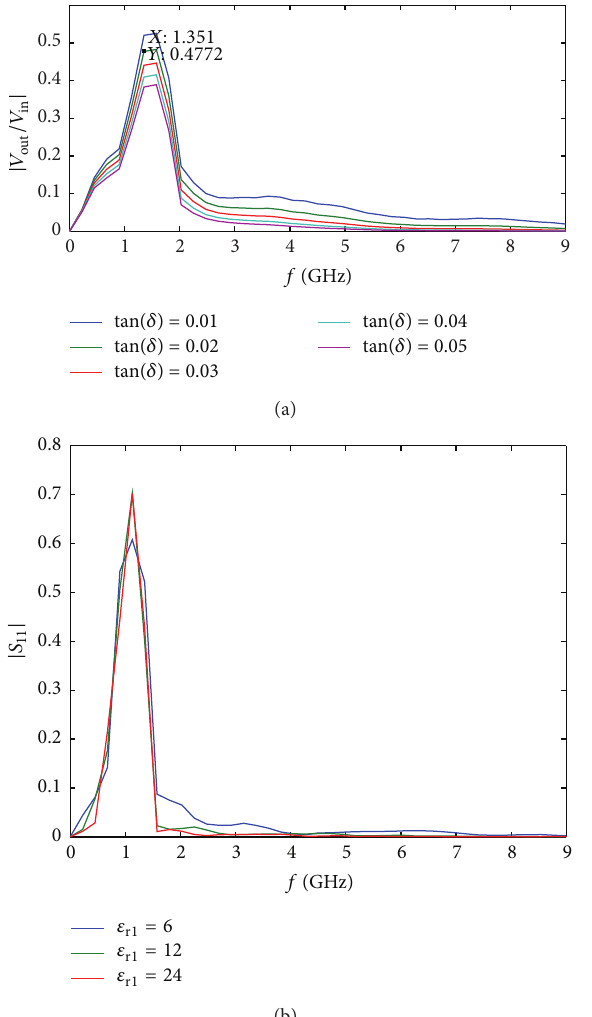
Figure 4: |𝑆 11 | model prediction varying tan (𝛿) (a) and 𝜀 𝑟1 (b).